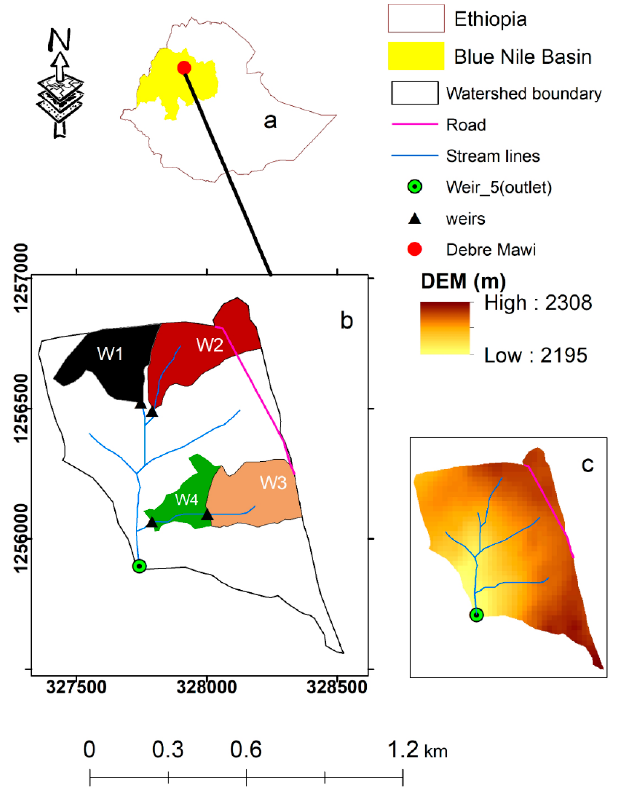
Figure 1. Location of Debre Mawi watershed and map of its four nested watersheds: ( a ) The location of the Debre Mawi watershed in the Upper Blue Nile Basin. ( b ) The Debre Mawi watershed consisting of the main watershed W5 together with the nested watersheds W1, W2, W3, and W4. The coordinates are in UTM. ( c ) The digital elevation map of the Debre Mawi watershed.